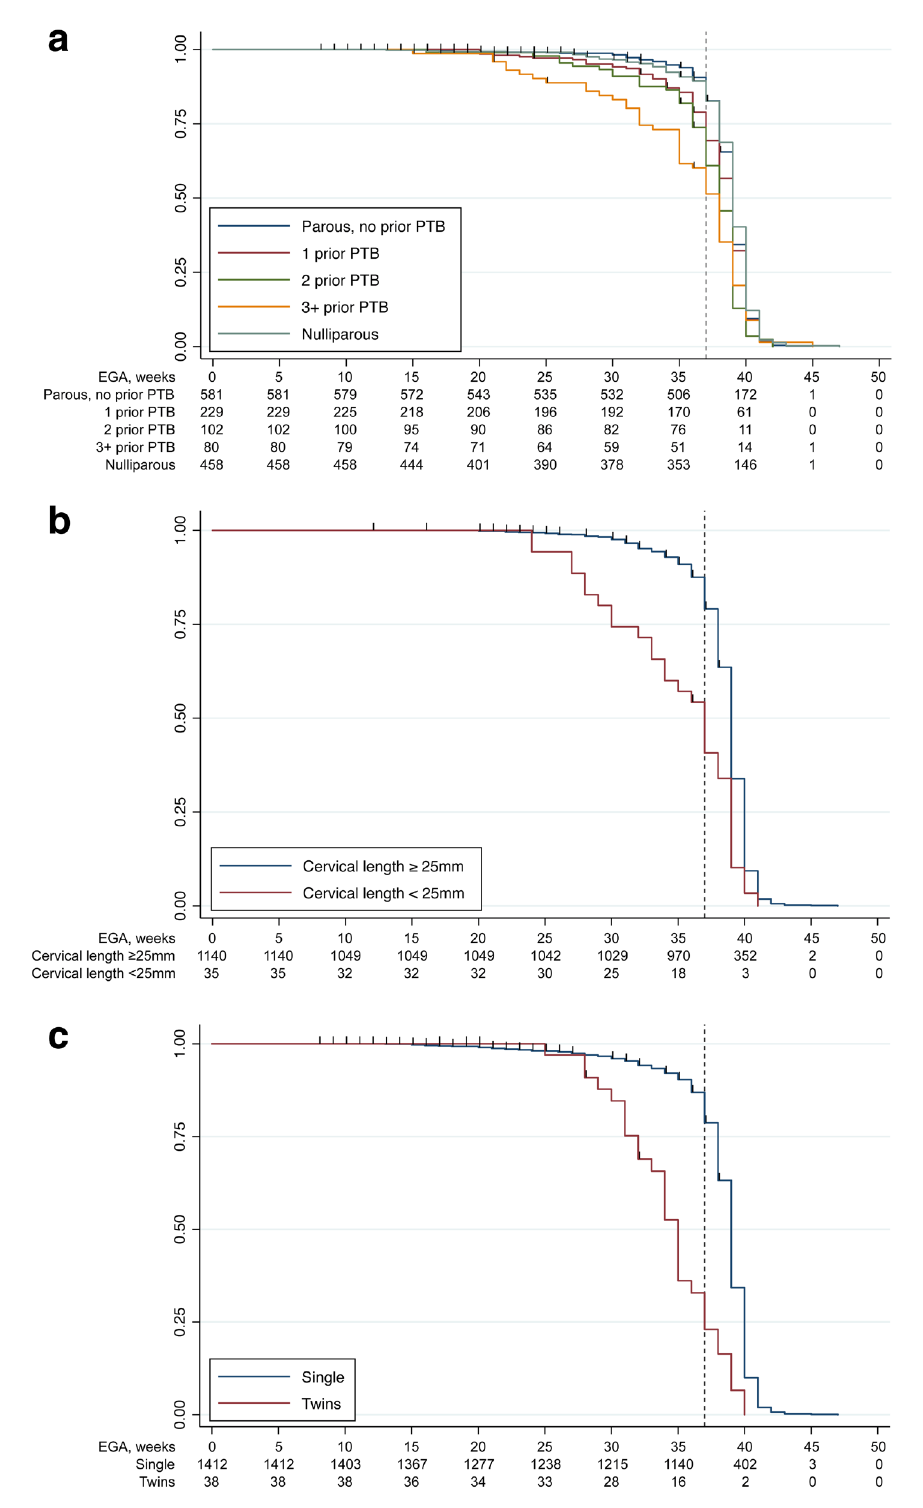
Figure 5. Kaplan-Meier survival curves by ( a ) prior preterm birth, ( b ) short cervix (<25mm), and ( c ) twin gestation. Survival curves are presented for participants with increasing numbers of prior preterm birth, those with cervical length <25mm compared to ≥ 25 mm, and those with twin compared to singleton gestation. The dashed vertical line represents a gestational age of 37 weeks, the threshold for preterm versus term delivery. EGA, estimated gestational age; PTB, preterm